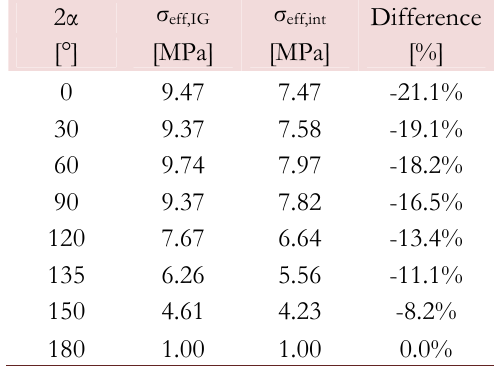
Figure 3: Trend of σ eff,IG VS σ eff,int